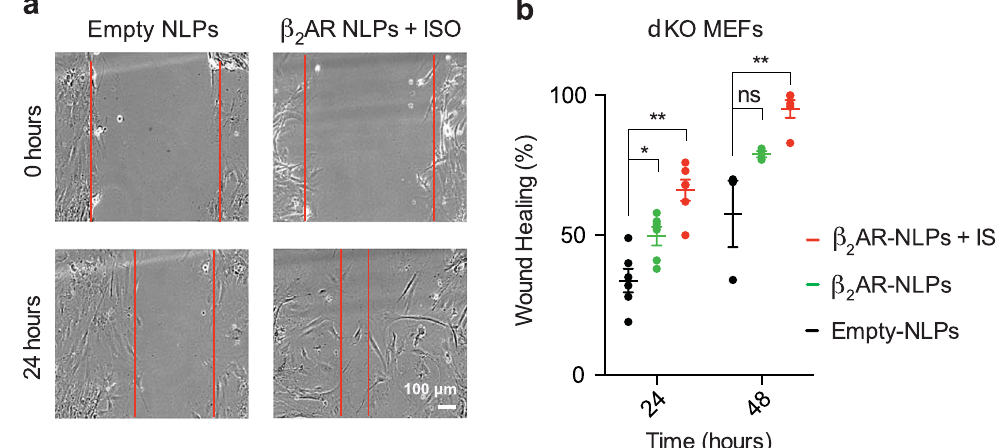
Figure 6. Nanodelivered β 2 AR increases rescues wound healing defects of β 1 / β 2 AR dKO mouse embryonic fibroblasts (MEFs). ( a ) Representative images of dKO MEFs treated with β 2 AR-NLPs or empty NLPs with or without isoproterenol and subjected to scratch assay for cell migration. Wound healing was analyzed at 24 and 48 hours. Red lines represent the cell front. ( b ) Wound healing was quantified as percentage of gap closure. Results are shown as mean ± S.E. ( * p < 0.05, ** p < 0.01, n = 3, unpaired t